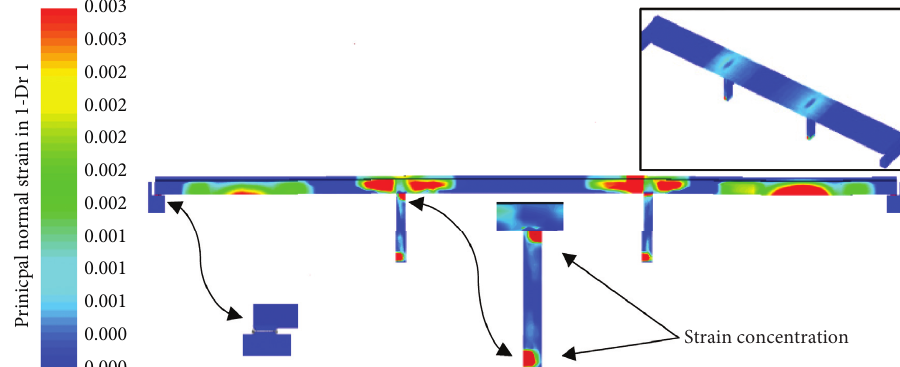
Figure 19: Principal normal strain of model “A1-M-K.”